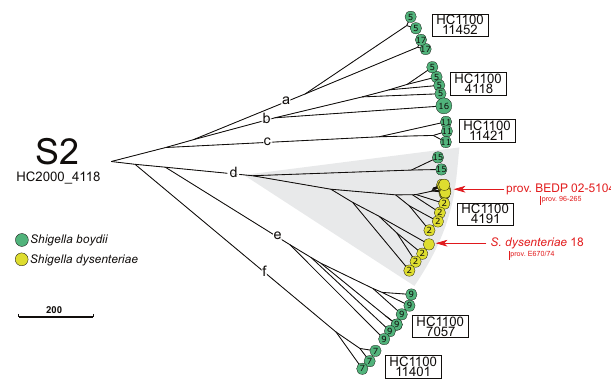
Fig. 3 A NINJA NJ GrapeTree showing the population structure of the Shigella S2 cluster (HC2000_4118). This subtree is based on the tree shown in Fig. 1. The tree nodes are colour-coded by serogroup. The numbers within nodes indicate the serotype. HC1100 designation is indicated next to each subcluster. Provisional (prov.) Shigella serotypes are also shown. The scale bar indicates the number of cgMLST allelic